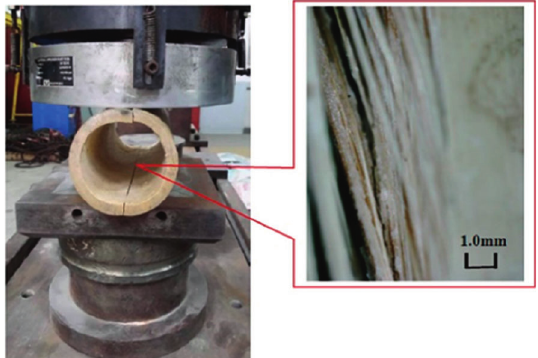
Figure 4: Optical microscope image of the failed tensile splitting specimen.